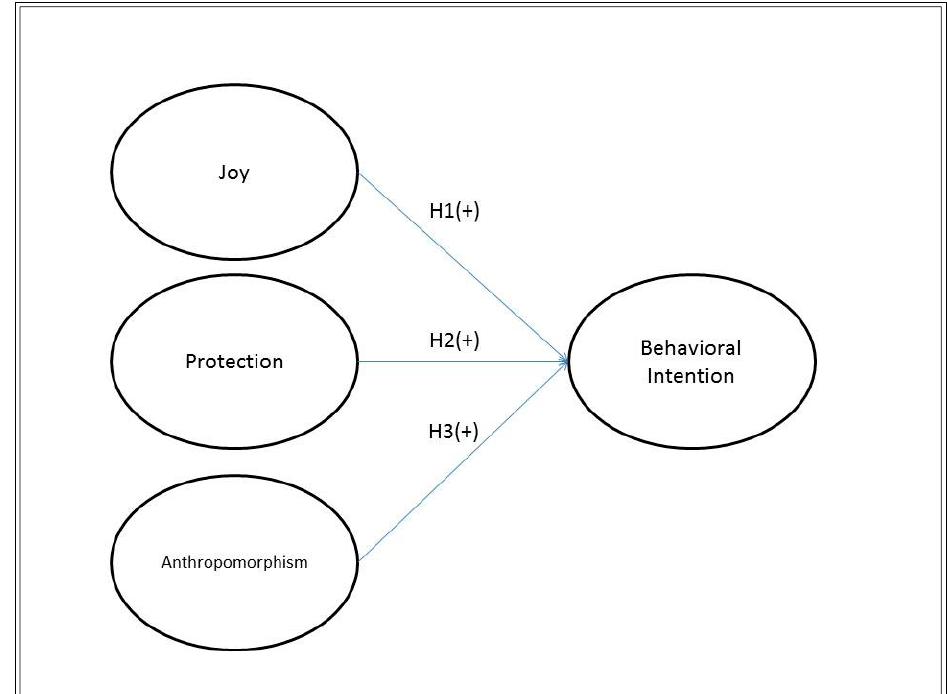
Figure 1. Research conceptual framework.